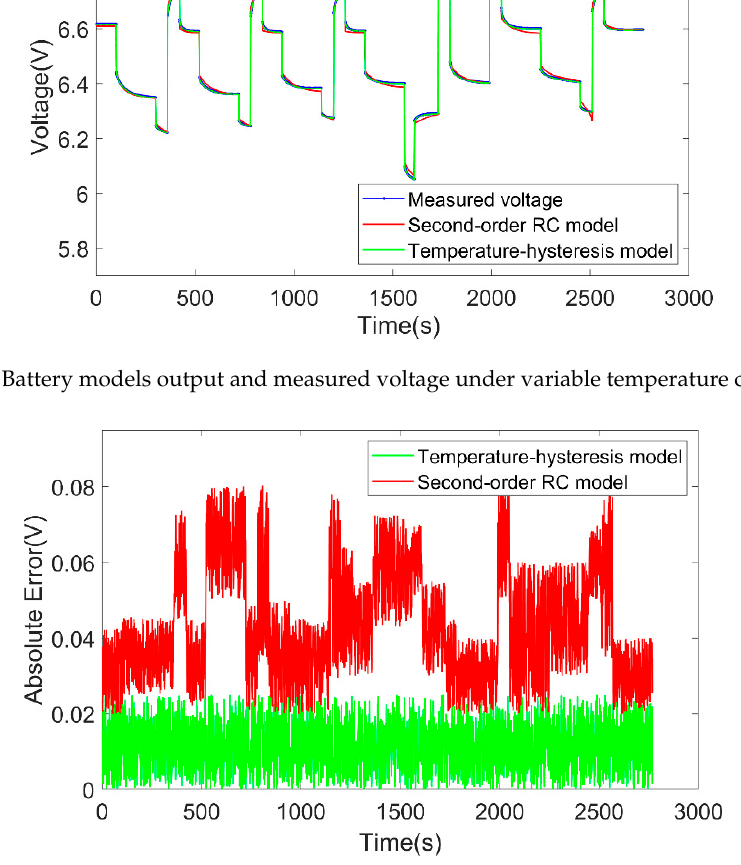
Table 5. Parameters of the adaptive unscented Kalman filter (AUKF) algorithm.